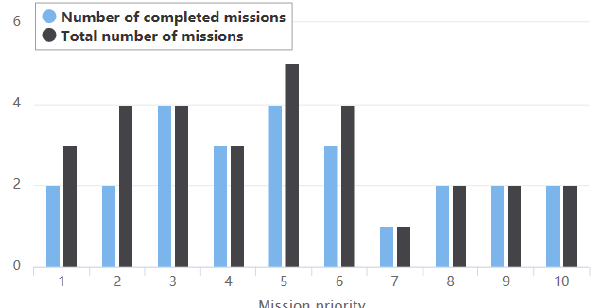
Figure 3. The completed number and total number of missions with different priorities in the dynamic scheduling plan.